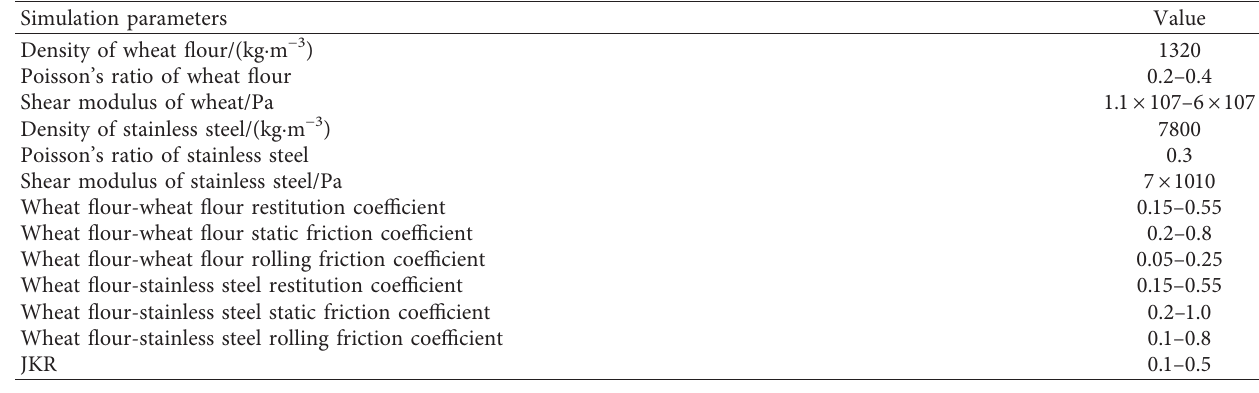
Table 1: Parameters required in DEM